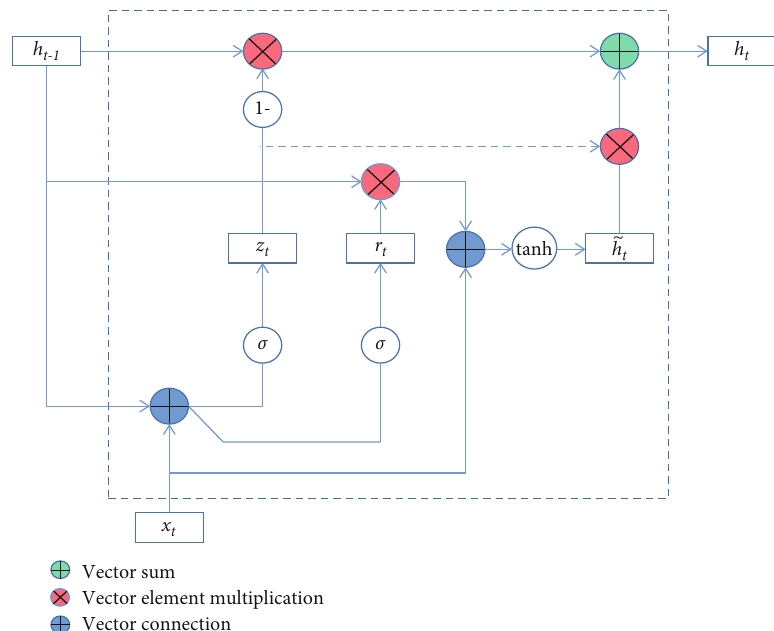
Figure 2: The internal structure of GRU.